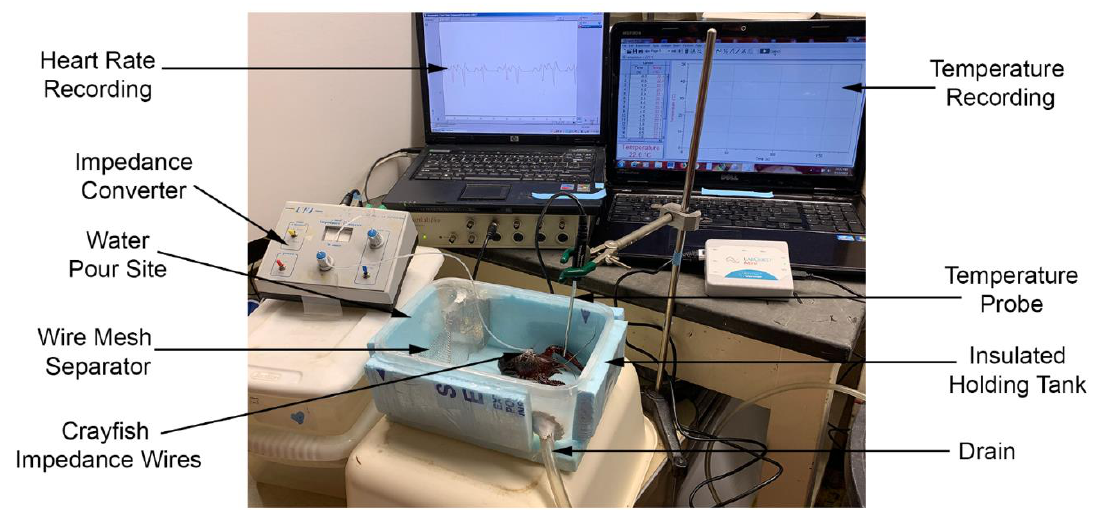
Figure 2. Recroding set up for ECGs while changing the water at various temperatures. The ECG leads were fed into the impedance converter which in turn was fed to an A / D board to record on a computer. The temperature probe was fed to a Vernier A / D converter to then record on a computer. The plastic chamber had insulation around it and a wire mesh on one side placed in the chamber to disseminate the water flow. A drain tube allowed the water to be removed as the new water was added at different temperatures.